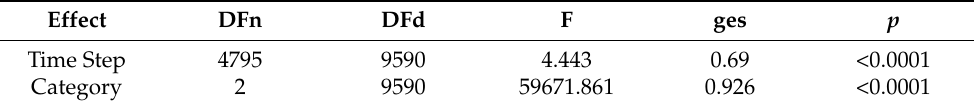
Table 1. ANCOVA of the simulated structures RMSD (all residues) after adjusting for the time steps. Effect